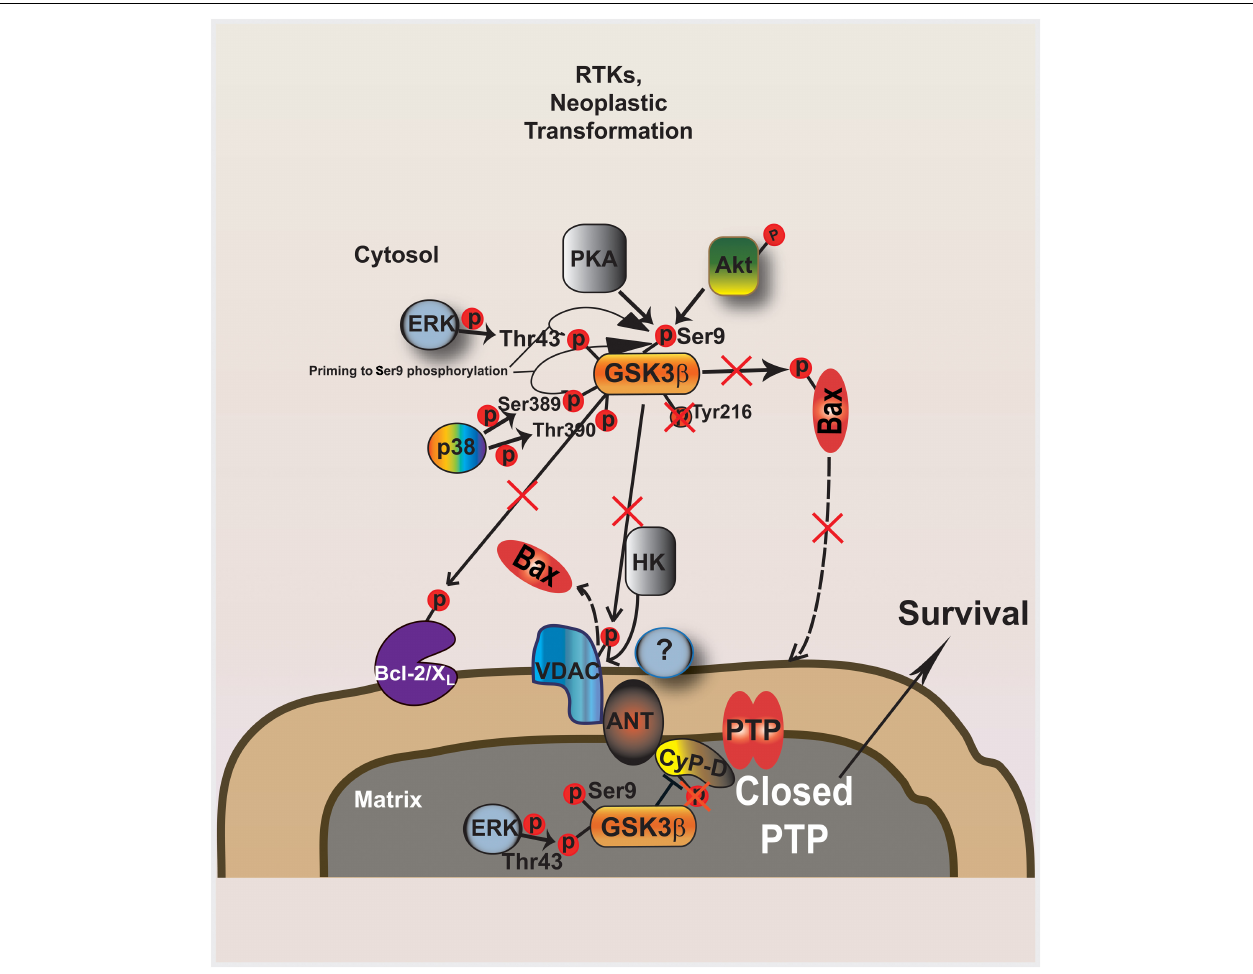
defuse the mitochondrial apoptotic machinery downstream to ligand- or oncogenically activated receptor tyrosine kinases. GSK-3 inhibitory phosphorylation in enhanced by regulatory loops that involve ERK and p38 MAPK targeting other Ser andThr residues on GSK-3. PTP inhibition is elicited both by dephosphorylatedVDAC, which has high affinity for HK II and competitively displaces Bax from the OMM, and by active mitochondrial ERK, which inhibits mGSK-3 by Ser phosphorylation, in turn blocking CyP-D phosphorylation and PTP induction. Contextually, the absence of GSK-3-dependent Bax activation inhibits Bax relocation in the